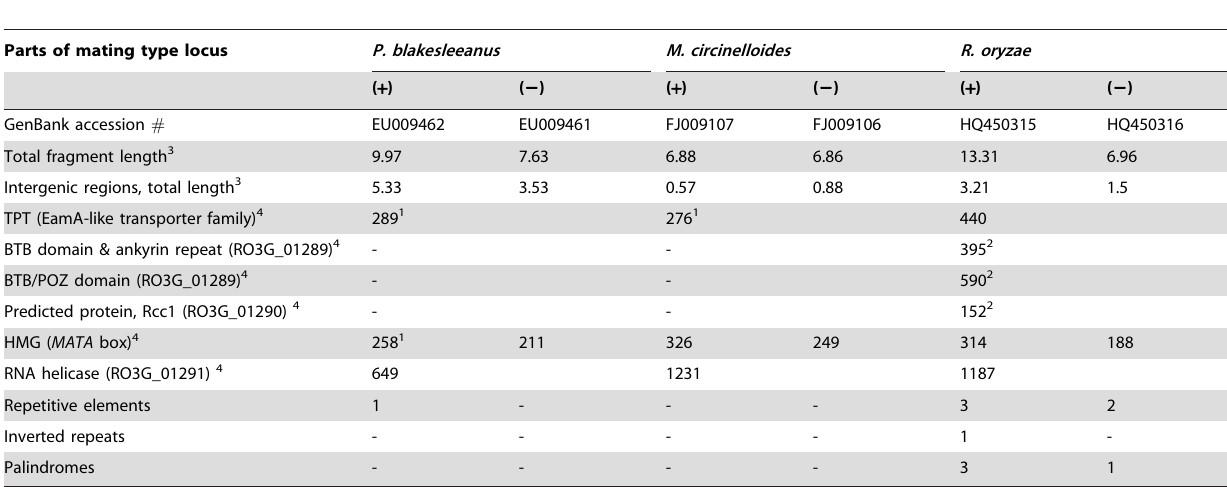
Table 2. Comparison of the number of genes, the length of individual genes, and the length of the entire gene complex in the sex loci of P. blakesleeanus, M. circinelloides and R. oryzae complex.